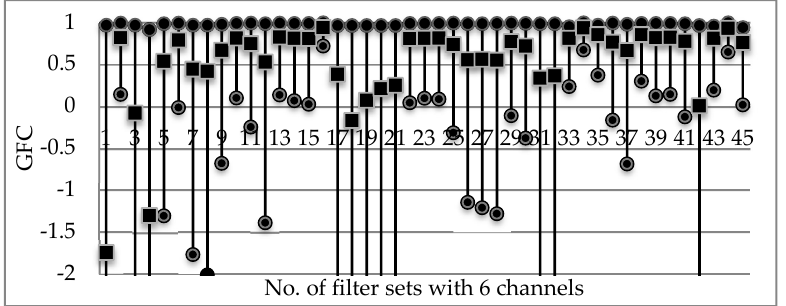
Figure 3. Overall performances of the 45 series of filter sets for 6 channels in terms of GFC, where the upper round marker denotes the maximum value; the middle square denotes the mean; and the lower round denotes the minimum (some of the minimums with negative value less than −2 are not be displayed).